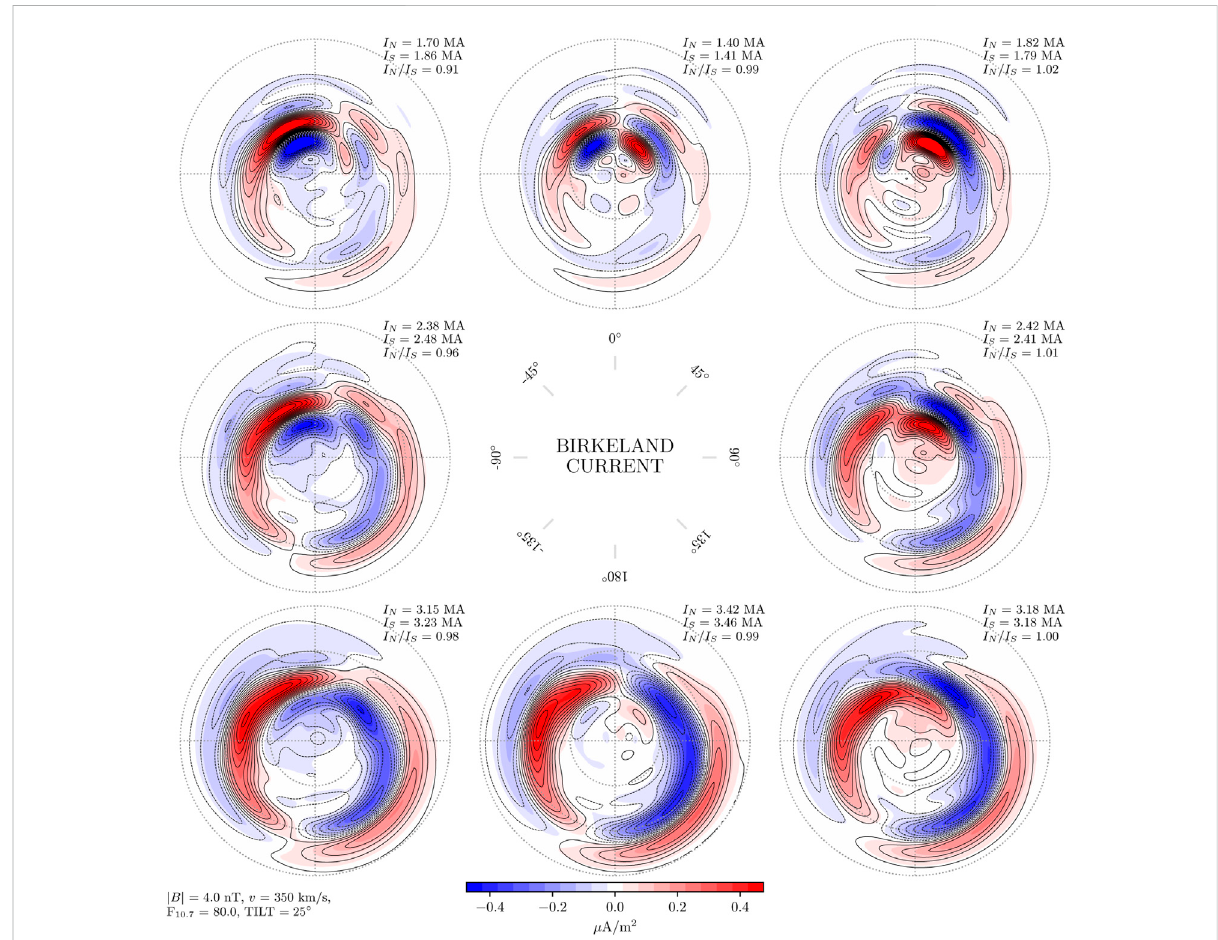
FIGURE 4 Amplitude of Birkeland currents in the Northern Hemisphere (colored contours) and Southern Hemisphere (black contour lines) for dipole tilt angle ψ =25 ° ,inthesamelayoutasFigure2.Inthis fi gure,themeanhemisphericallyintegratedcurrentintheNorthernHemisphereis2%weakerthan in the Southern